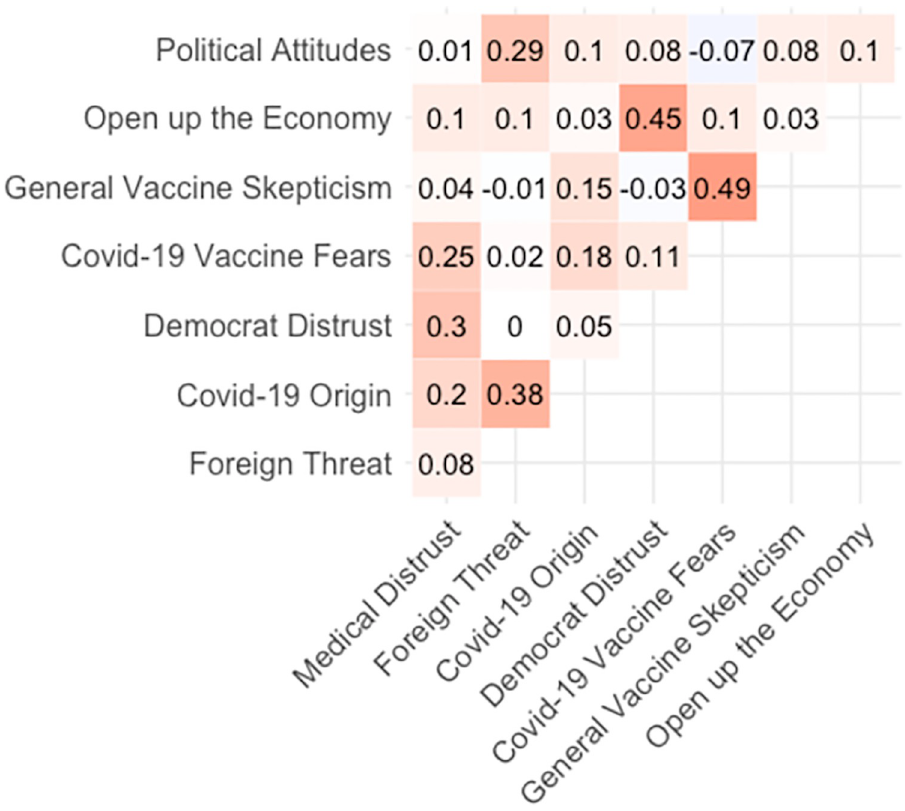
Fig 10. Pairwise partial correlations between beliefs based on first-wave survey. Higher values on the political attitudes scale implies more conservative political stance. The shading on each cell represents correlation value (darker red = stronger positive; darker purple = stronger